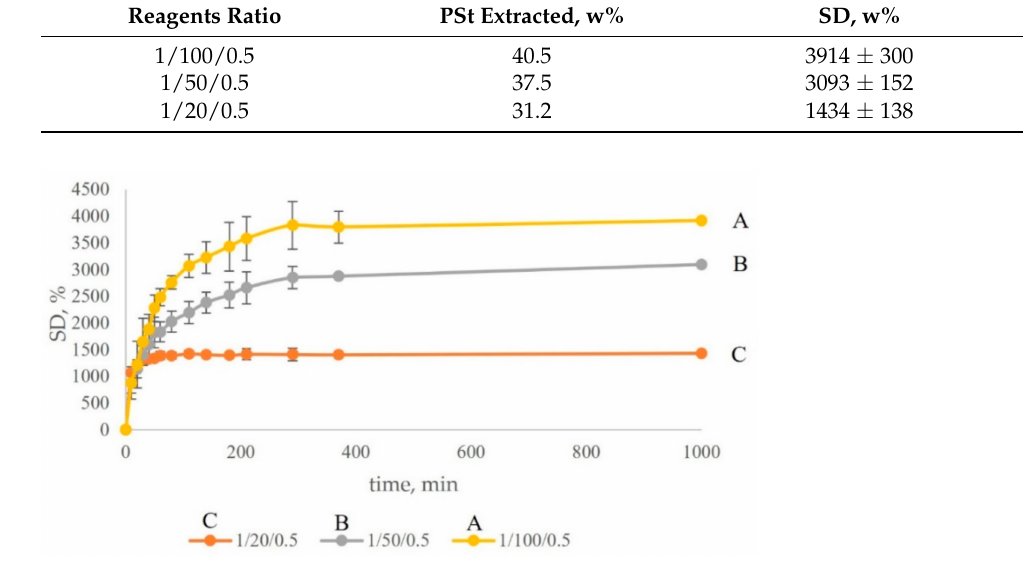
Figure 8. Swelling degree (SD, %) of the cellobiose-m gels with different components ratio of cellobiose-m/styrene/AIBN. ( A ) 1/100/0.5; ( B ) 1/50/0.5; ( C )